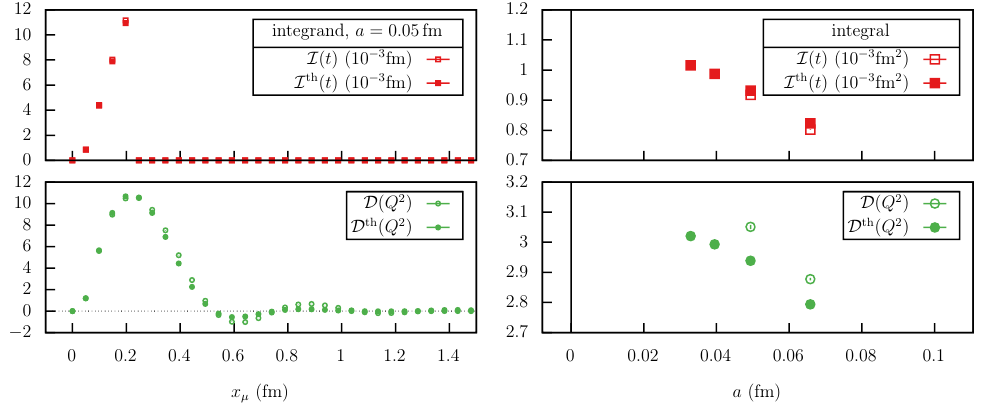
Figure 1 . Left panel: integrand of the fourth moment of the correlator (red squares) and the Adler function (green circles) at fixed lattice spacing. The vacuum and thermal observables are shown with open and filled symbols, respectively. Right panel: corresponding integral as a function of the lattice spacing is shown, which illustrates that the thermal contribution with T = 250 MeV accounts for most of the